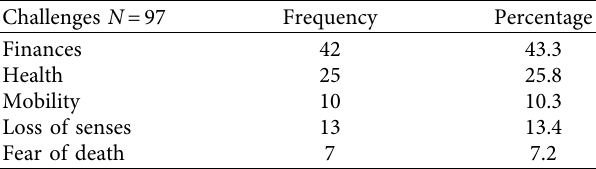
Table 4: General challenges of the elderly.